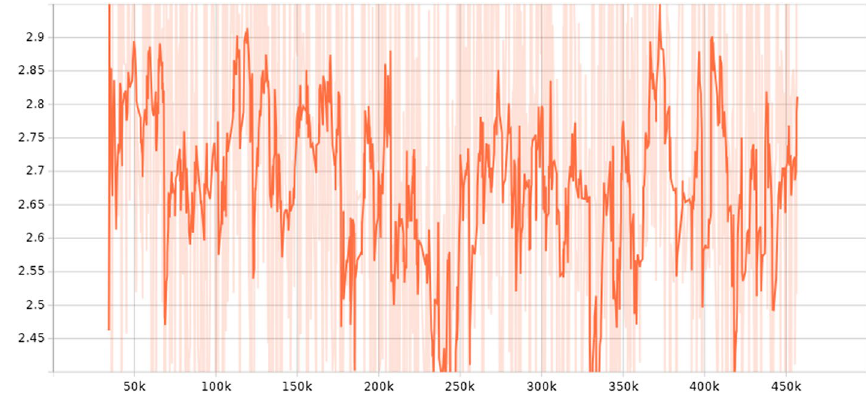
Fig. 3 Tensor-board training loss summary